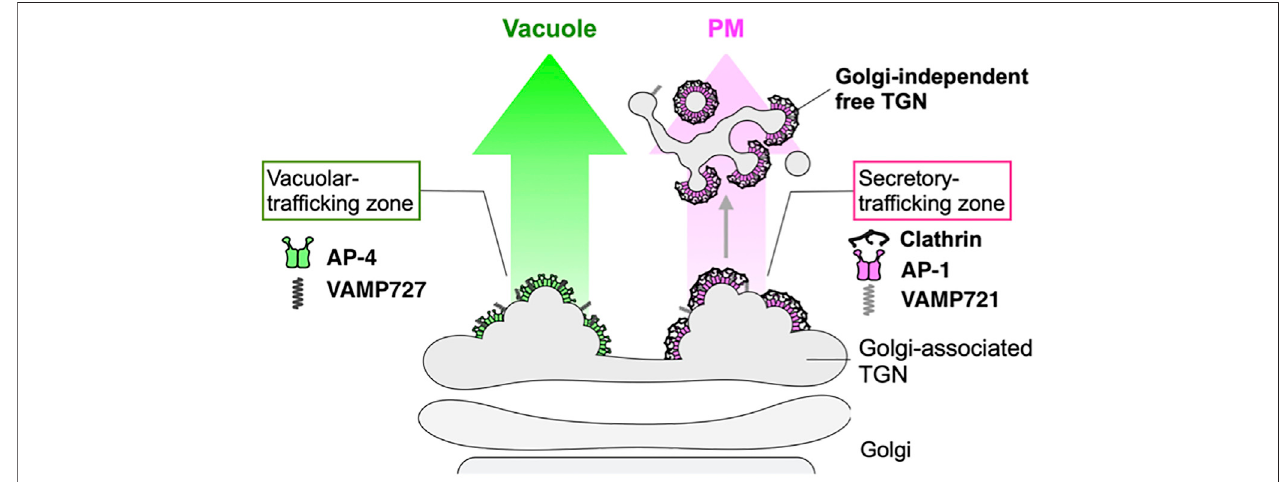
FIGURE 5 | Sorting zones in plant TGN differentiated for secretory and vacuolar traf fi cking. Cargo sorting events in root epidermal cells of Arabidopsis have been analyzed in detail by state-of-the-art live imaging (SCLIM) (Shimizu et al., 2021). TGN-localized proteins exhibit spatially and temporally distinct distribution. VAMP721 (R-SNARE),AP − 1,andclathrinwhichareinvolvedinsecretorytraf fi ckingcomposeanexclusivesubregion,whereasVAMP727(R-SNARE)andAP-4involvedinvacuolar traf fi cking compose another subregion on the same TGN. These fi ndings indicate that the single TGN has at least two subregions, or “ zones ” , responsible for distinct cargo sorting: the secretory-traf fi cking zone destined to the plasma membrane (PM) and the vacuolar-traf fi cking zone.